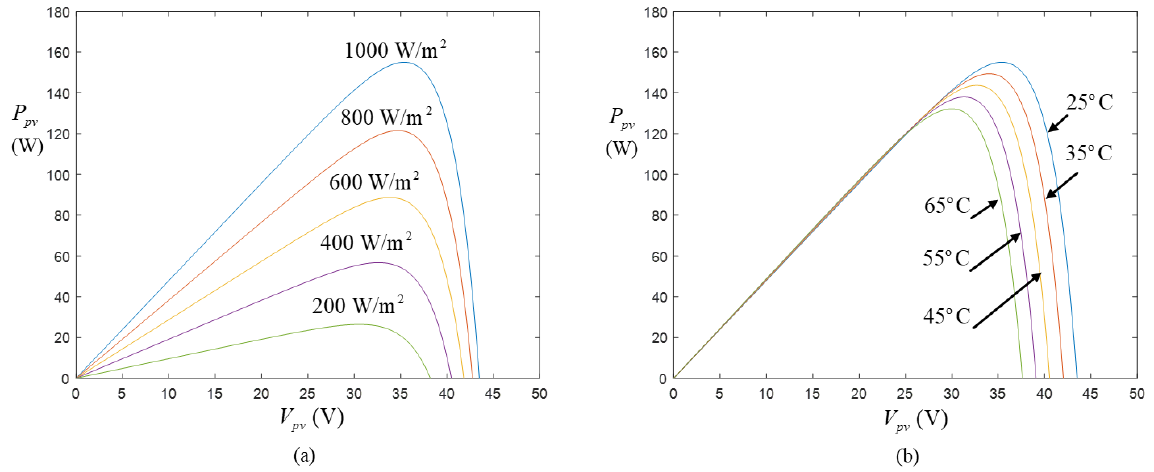
Figure 2. The power versus voltage curves: ( a ) for different solar irradiation, ( b ) for different temperature.